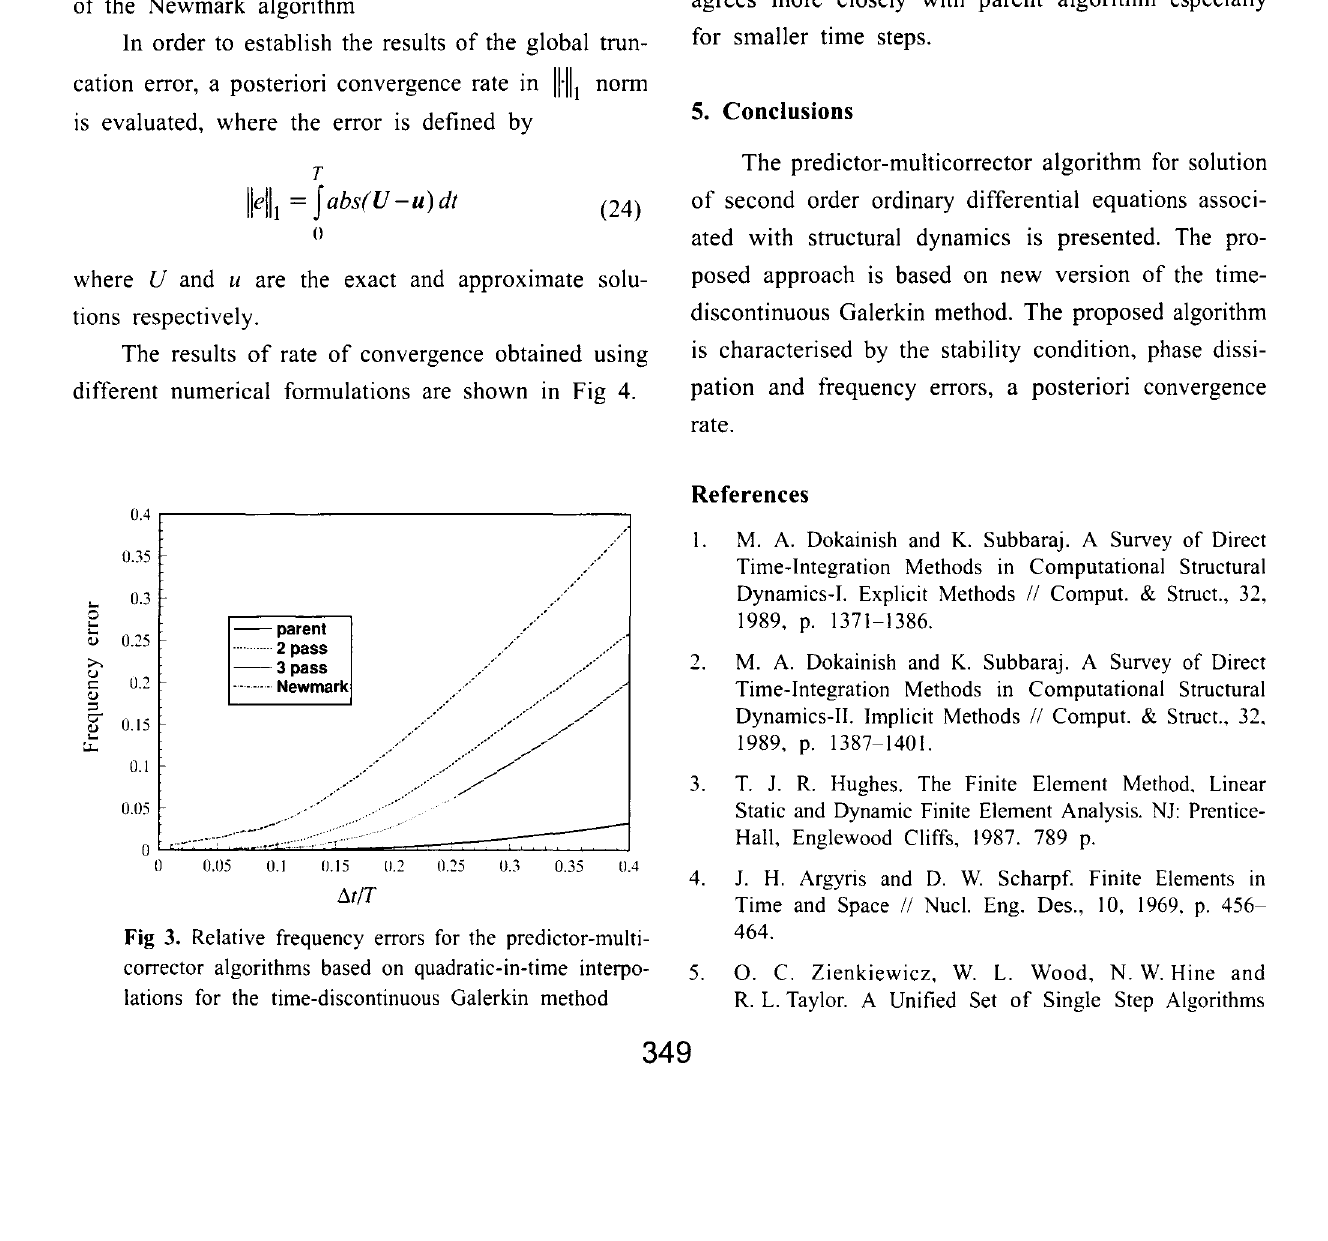
Fig 4. A posteriori rate of convergence by the